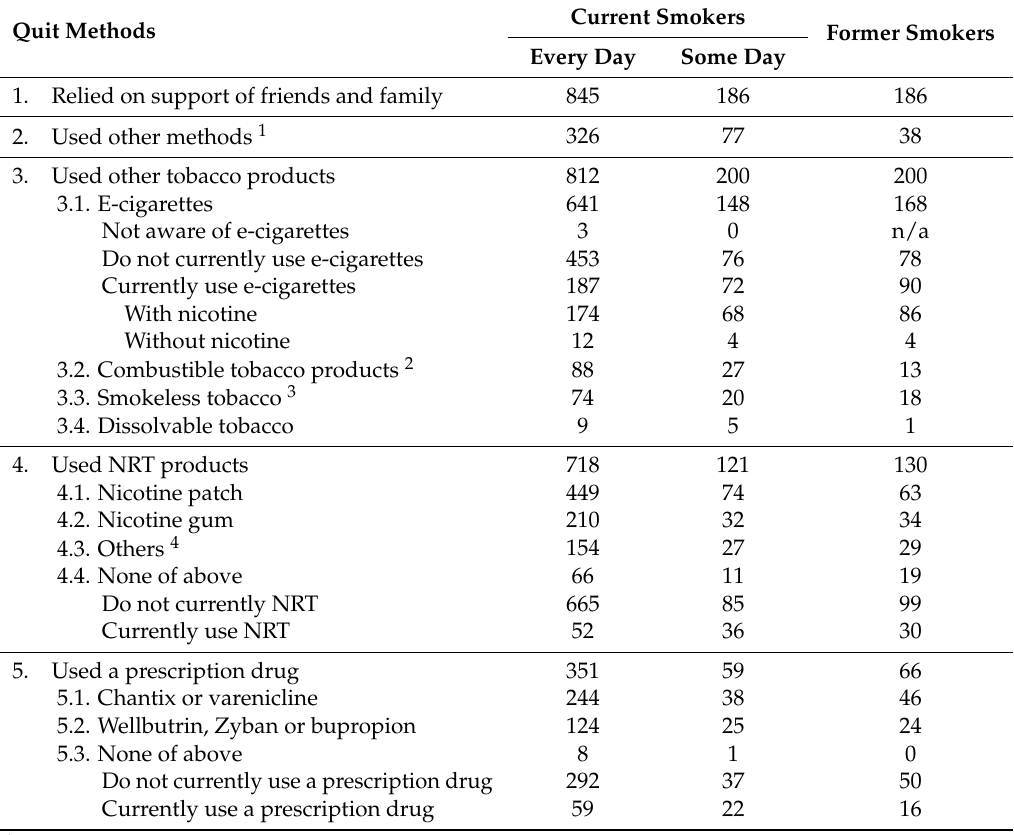
Table 5. Numbers of current and former smokers using two or more quit methods in the past 12